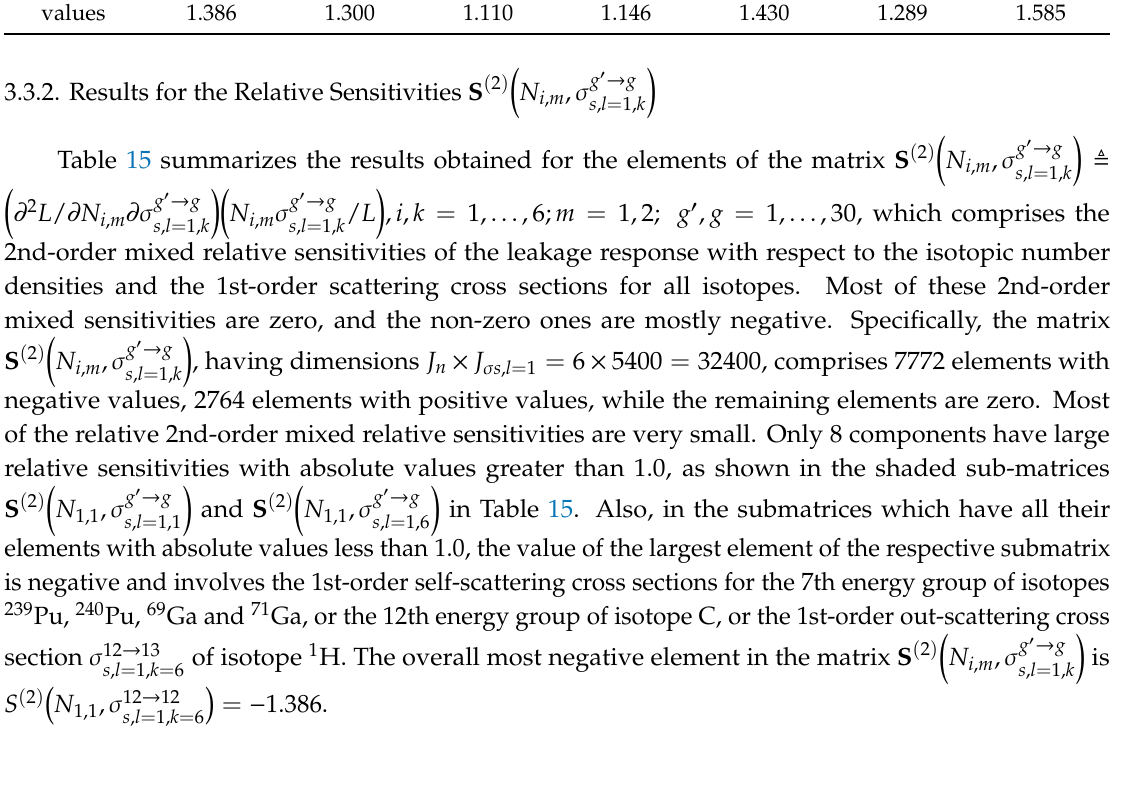
(cid:17) , g (cid:48) , g = 1, ... ,30 with absolute values greater than 1.0.